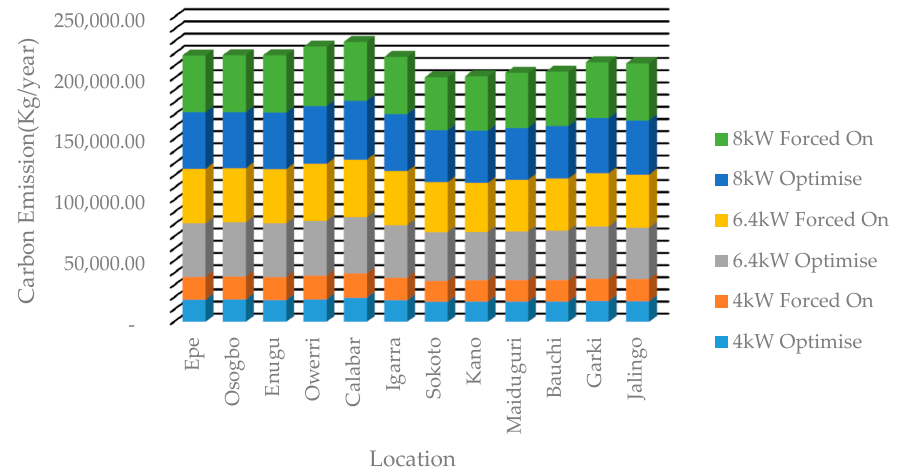
Figure 9. Total carbon emission for the location (kg/year).